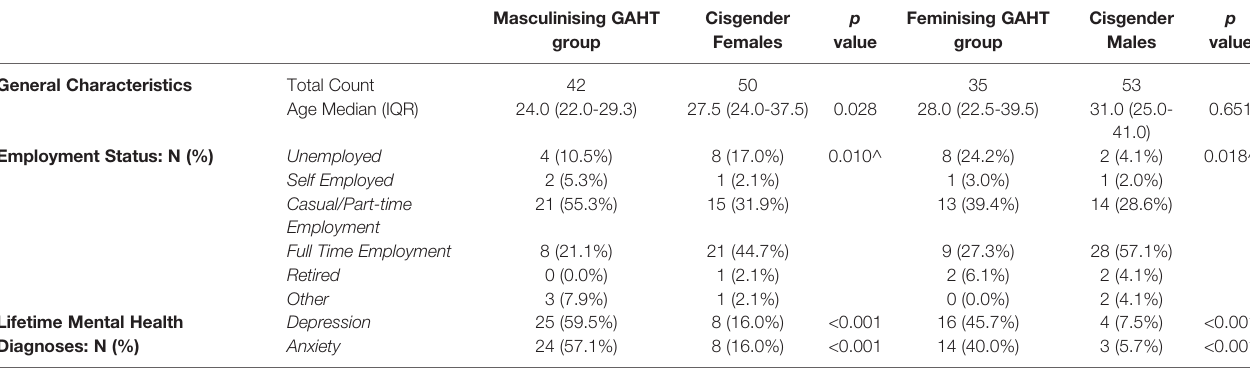
TABLE 1 | Characteristics of trans participants and cisgender comparison group matched for presumed sex at